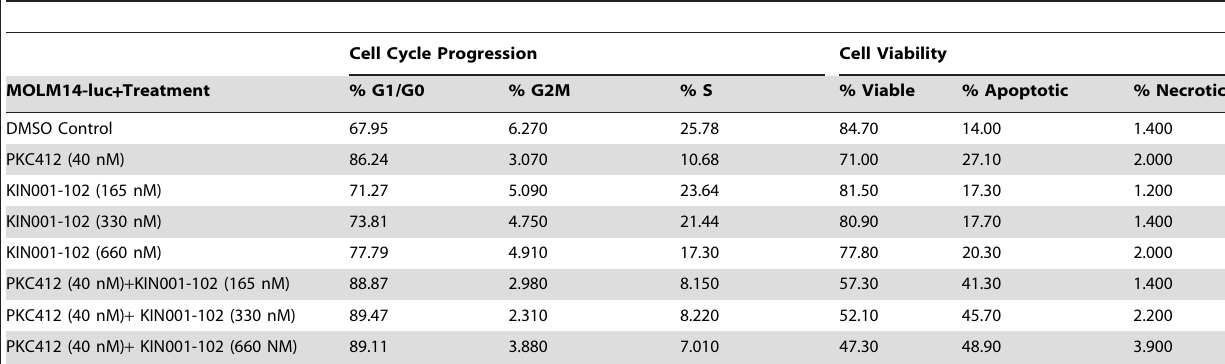
Table 1. Effects of PKC412 and KIN001-102, alone and combined, on MOLM14-luc + cell cycle progression (following 24 hours of treatment) and apoptosis (following 48 hours of treatment) when cells are cultured in the presence of 50% HS-5 SCM.